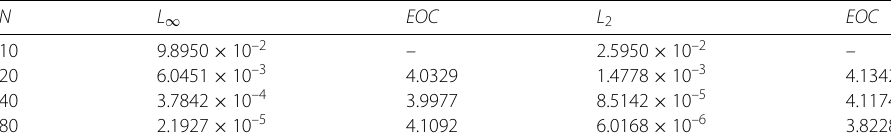
Table 3 Experimental order of convergence for Problem 1, when α = 1.50, N = 80, (cid:2) t = 0.001 N L ∞